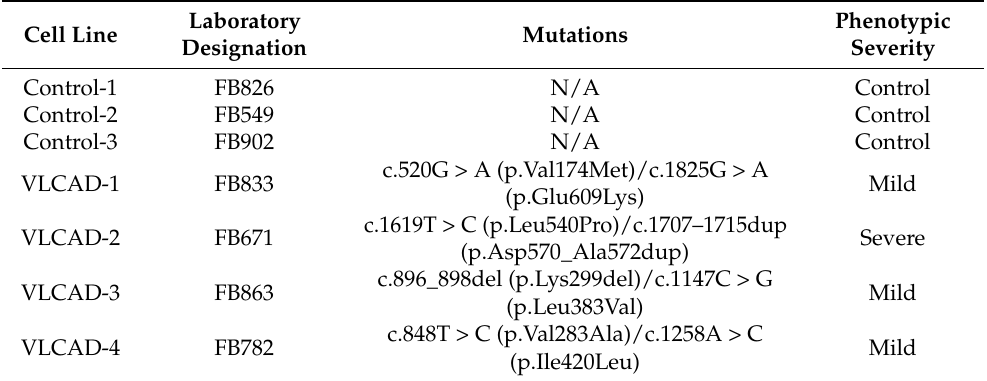
Table 1. List of VLCAD-deficient cell lines used in this project with their corresponding mutations in ACADVL and phenotypic